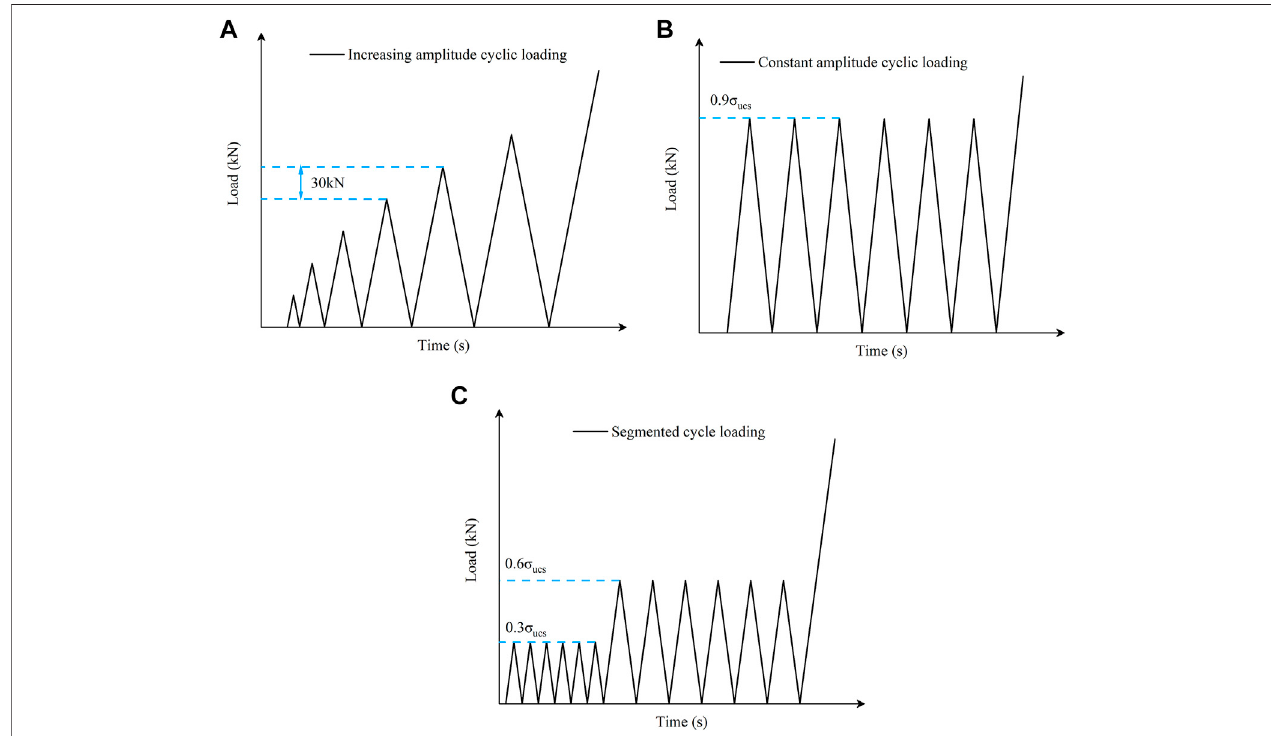
FIGURE 3 | Corresponding curves for load and time with different cyclic loading paths. (A) Waveforms with stepwise increasing amplitudes; (B) Waveforms with constant amplitudes; (C) Waveforms with multi-level cyclic amplitude.